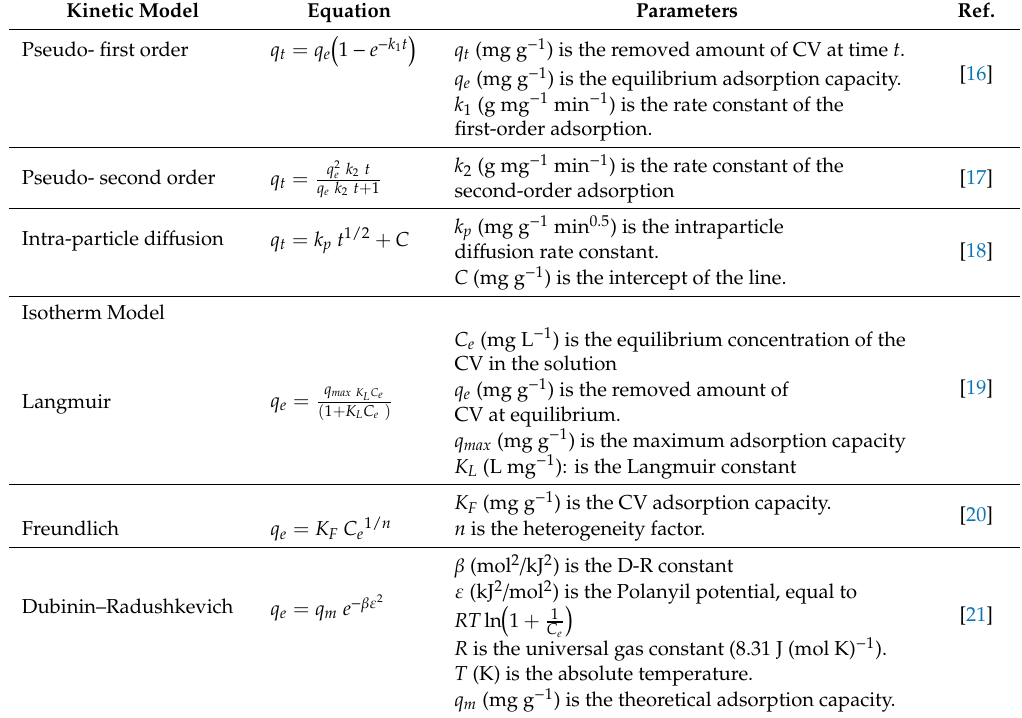
Table 1. Kinetic and isotherm models used to fit the adsorption of CV on the MNP / CTAB-EC composite. Kinetic Model Equation Parameters